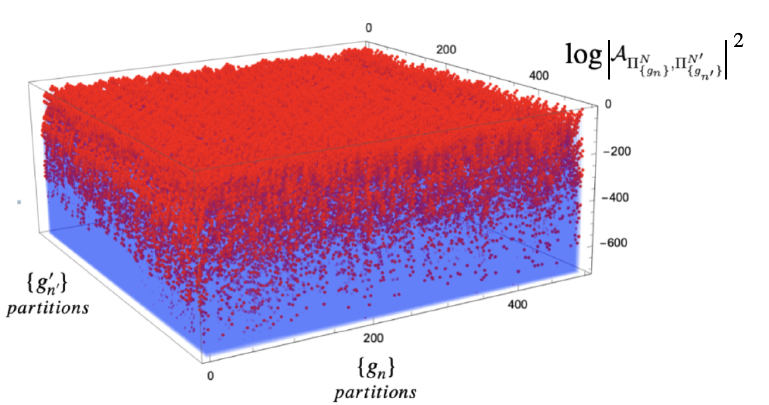
Figure 10 . Microstates population of the decay rate in logarithmic scale for 500 random partitions { g n } of N = 100 and 500 random partitions { g 0 decay